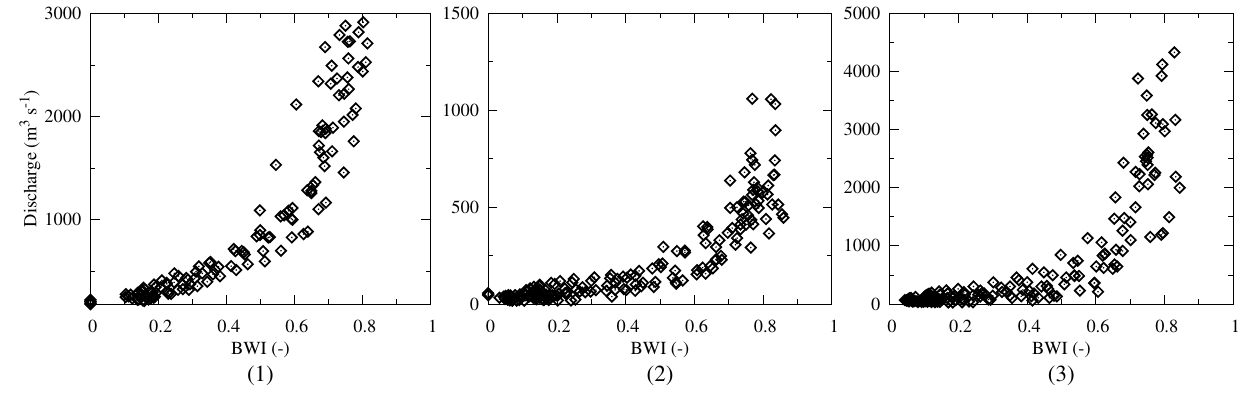
Fig. 3. Correlation between Basin Water Index (BWI) and discharge shifted by the time lag ( 1τ ) which resulted in the best correlation.